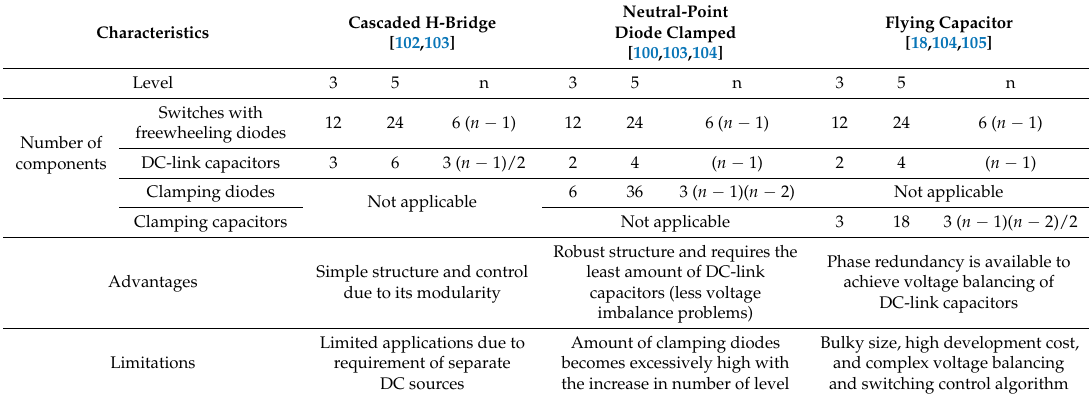
Table 1. Comparison of multilevel inverter characteristics in three-phase